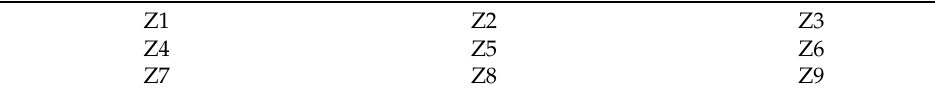
Table 2. Floating image matrix, size 3 × 3.